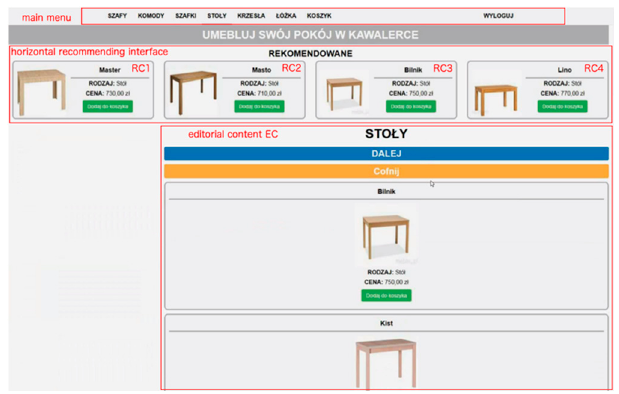
Figure 5. Horizontal layout of the recommending interface.